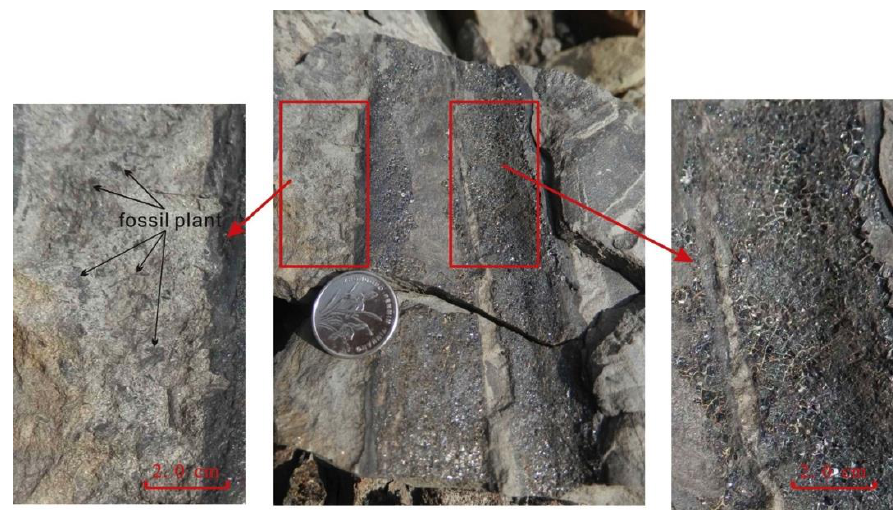
Figure 8. Regular rhombus imprints on the bedding surface of two parts of a Late Permian coal sample from the Liupanshui coalfield: ( a ) the part above the bedding surface; ( b ) the part below the bedding surface.